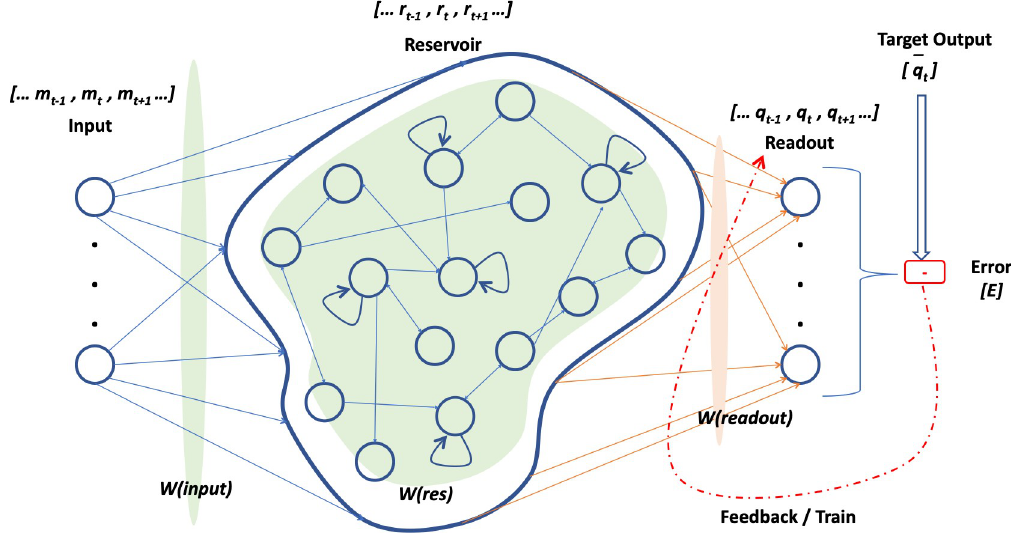
Fig 1. Basic anatomy of recurrent neural